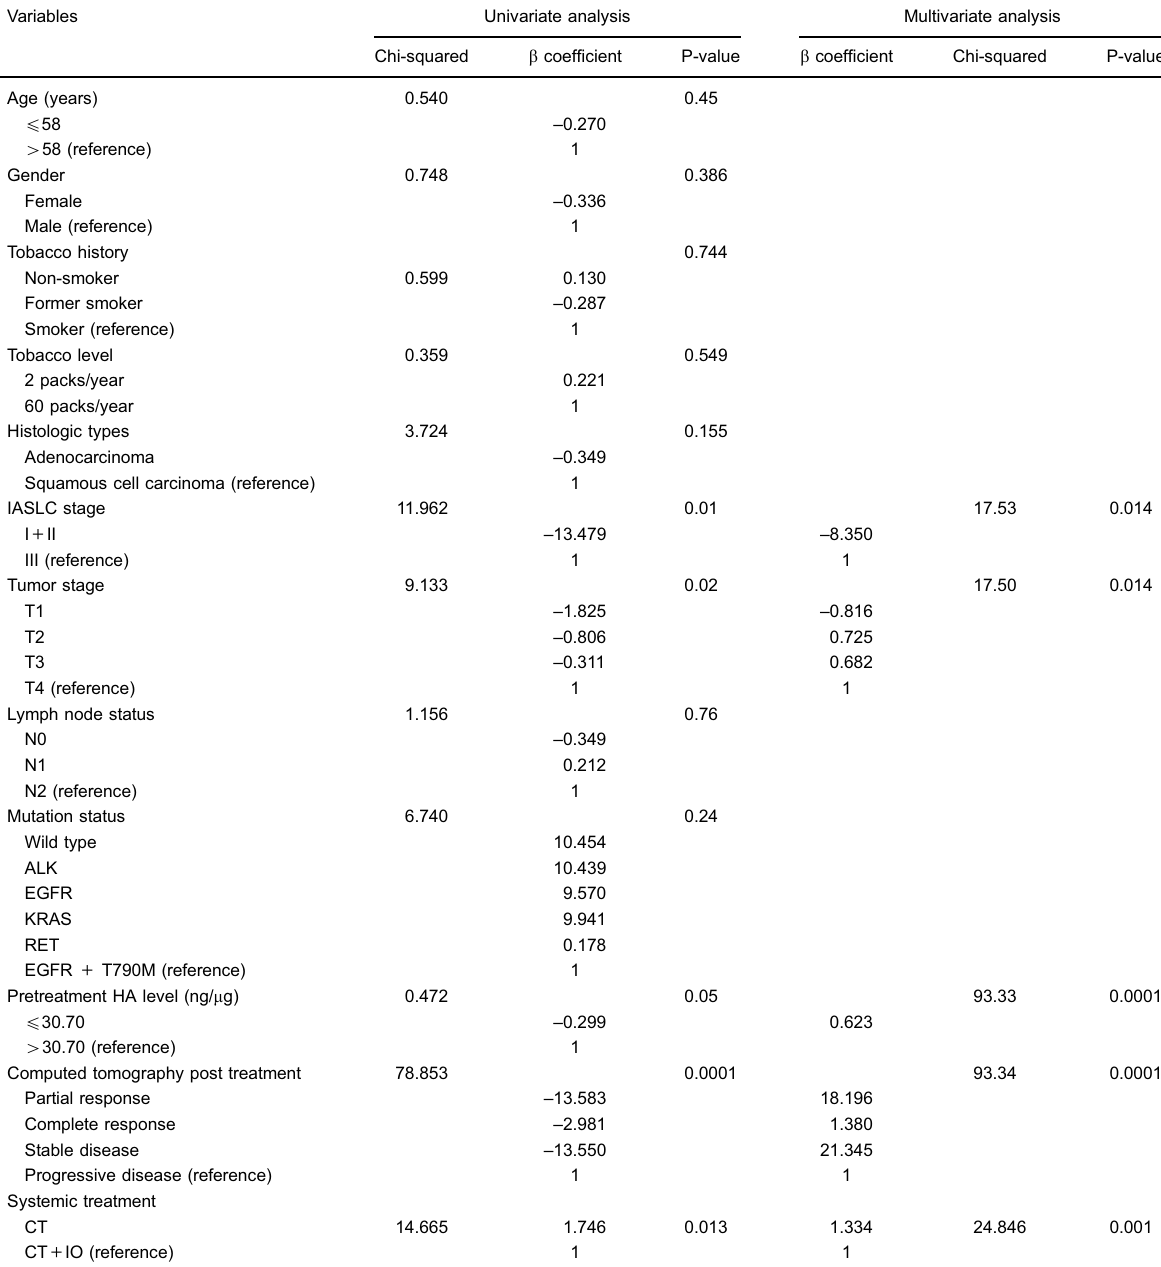
Table 2 . Univariate and multivariate analysis using a Cox proportional hazards model of the variables associated with overall survival (OS).